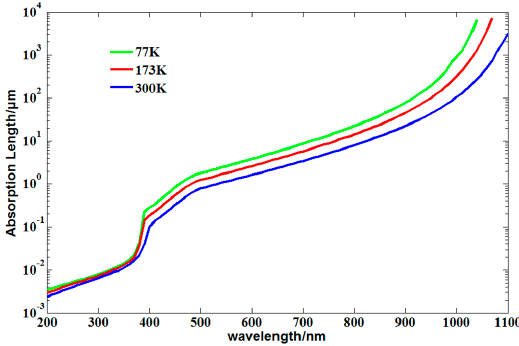
Figure 1. Absorption length in silicon versus wavelength at temperatures of 77, 173, and 300 K.